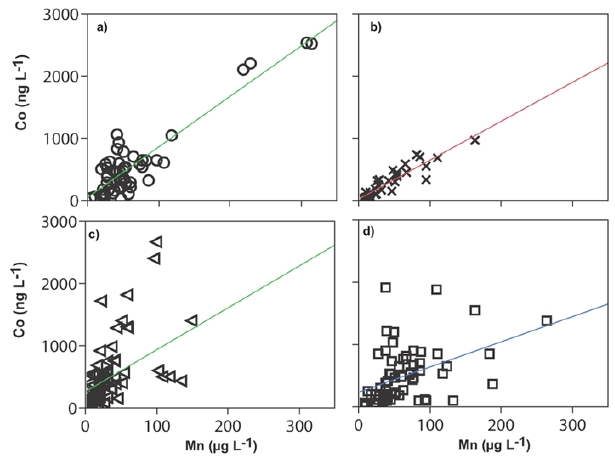
Fig. 7. Concentration of total cobalt (ngL − 1 ) against total man- ganese (µgL − 1 ) at the four rivers (a) Danshytte˚an, (b) Getryggs˚an, (c) Anr˚ase ˚a and (d)